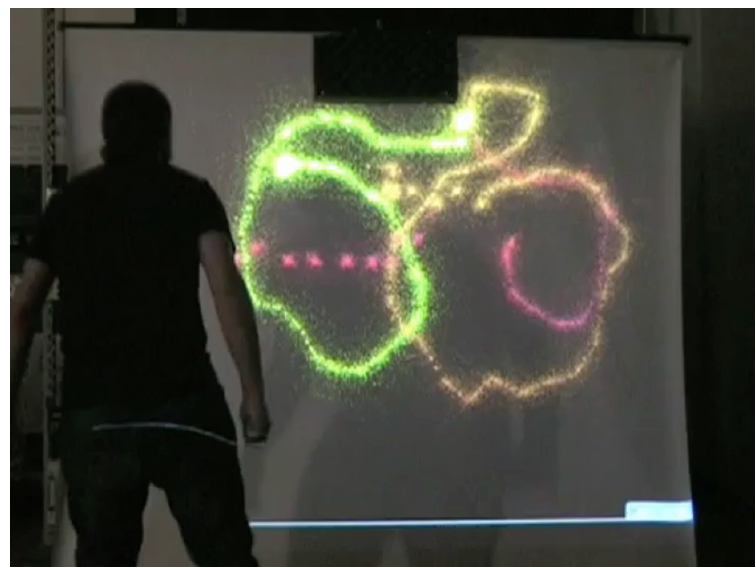
Figure 7. The installation Voice painter using body movements and vocal expression to create a